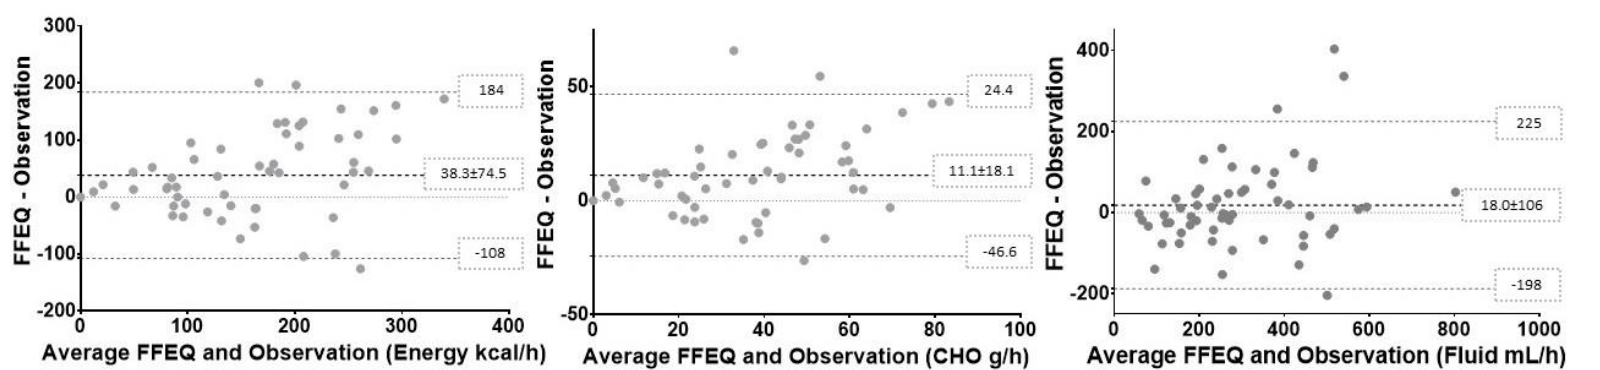
Figure 2. Bland – Altman figures for energy (kcal/h), carbohydrate (CHO) (g/h), and fluid intake (FLU) (mL/h), including 95% limits of agreement. Figure 2. Bland–Altman figures for energy (kcal / h), carbohydrate (CHO) (g / h), and fluid intake (FLU) (mL / h), including 95% limits of